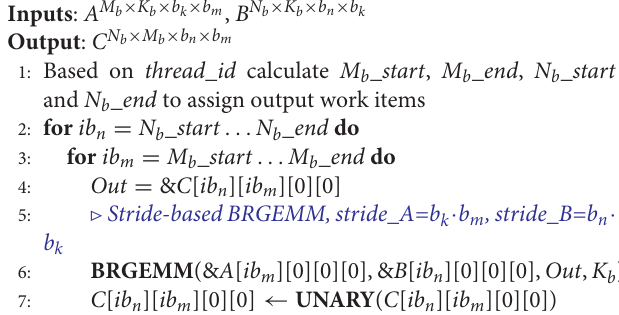
Algorithm 6 | Fully-Connected Layer with Unary Activation